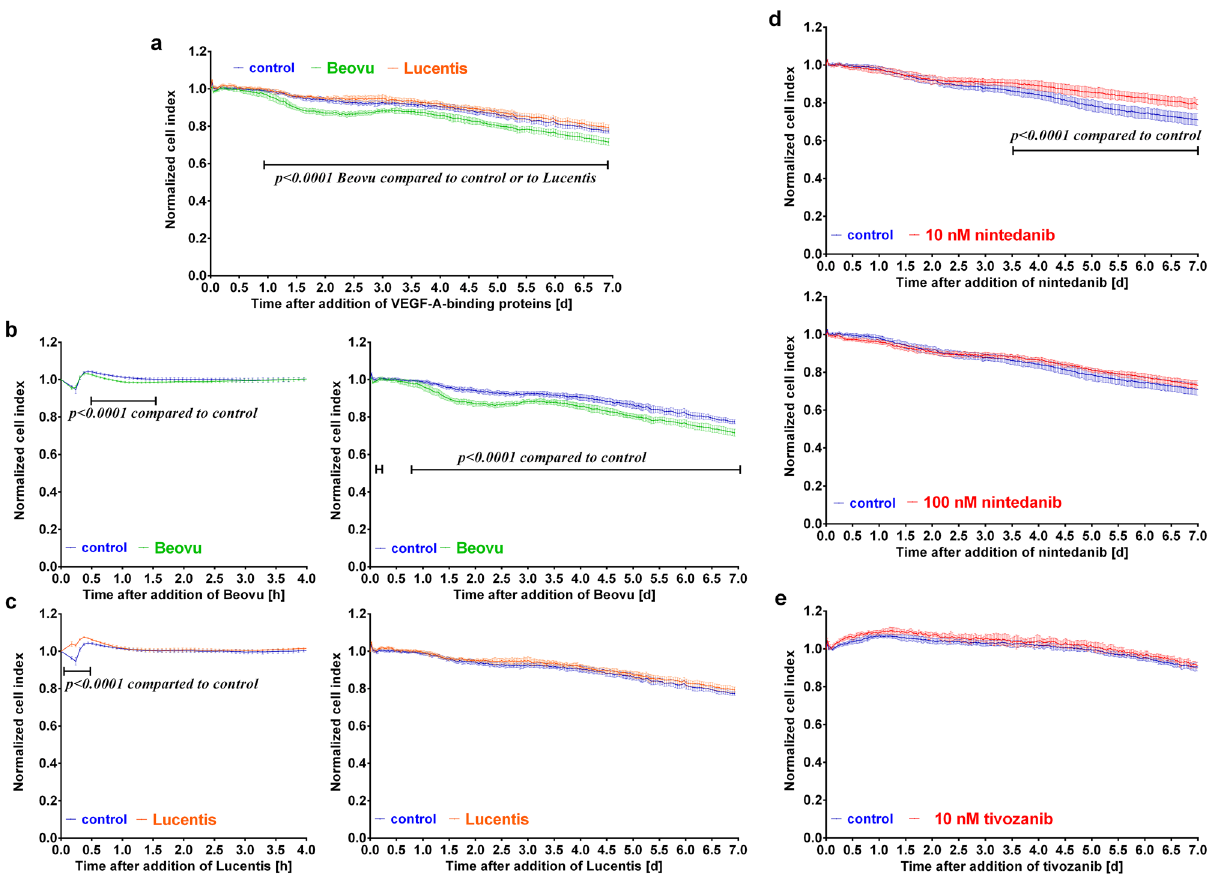
Figure 1. Beovu lowered the cell index of iBREC. iBREC were cultivated on gold electrodes until confluency was reached before ( a ) , ( b ) Beovu ( n = 7), ( a ), ( c ) Lucentis ( n = 6), ( d ) nintedanib ( n = 7), ( e ) tivozanib ( n = 3), or phosphate-buffered saline (control, blue curves; n ≥ 6) was added and the cell index recorded continuously as a measure of barrier function. Cell index values were normalized in relation to those measured immediately before addition of the VEGF-A antagonists and are shown as means with standard deviations. Data were analyzed with two-way ANOVA followed by Sidak’s multiple comparison test. ( a ), ( b ) Beovu significantly lowered the cell index values transiently early after its addition and persistently from ~ 1.5 days of exposure until the end of the experiment over seven days. ( a ), ( c ) Cell index values were not different in the presence of Lucentis. ( d ) Nintedanib (10 nM) significantly enhanced cell index values late after its addition, whereas the higher concentration (100 nM) had no effect. ( e ) Cell index values were also not changed by 10 nM